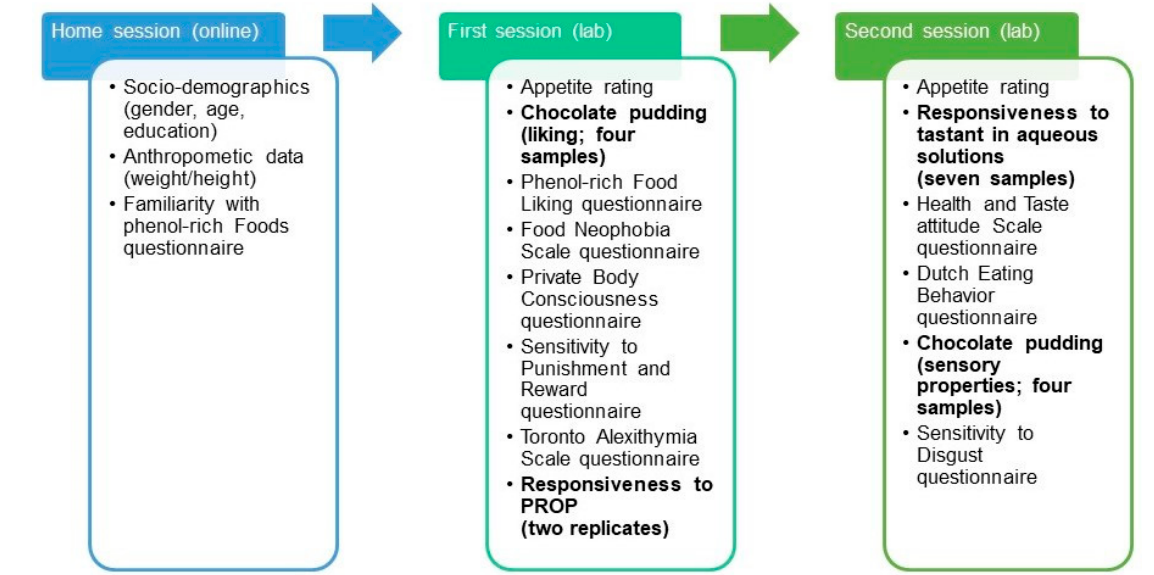
Figure 1. Overview of data collections. Sensory tests that included the evaluation of samples (food products or solutions) are emboldened.